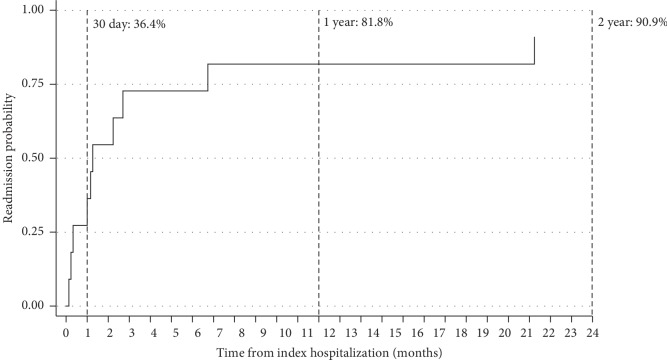
Kaplan–Meier curve for readmission after emergency transcatheter aortic valve replacement.